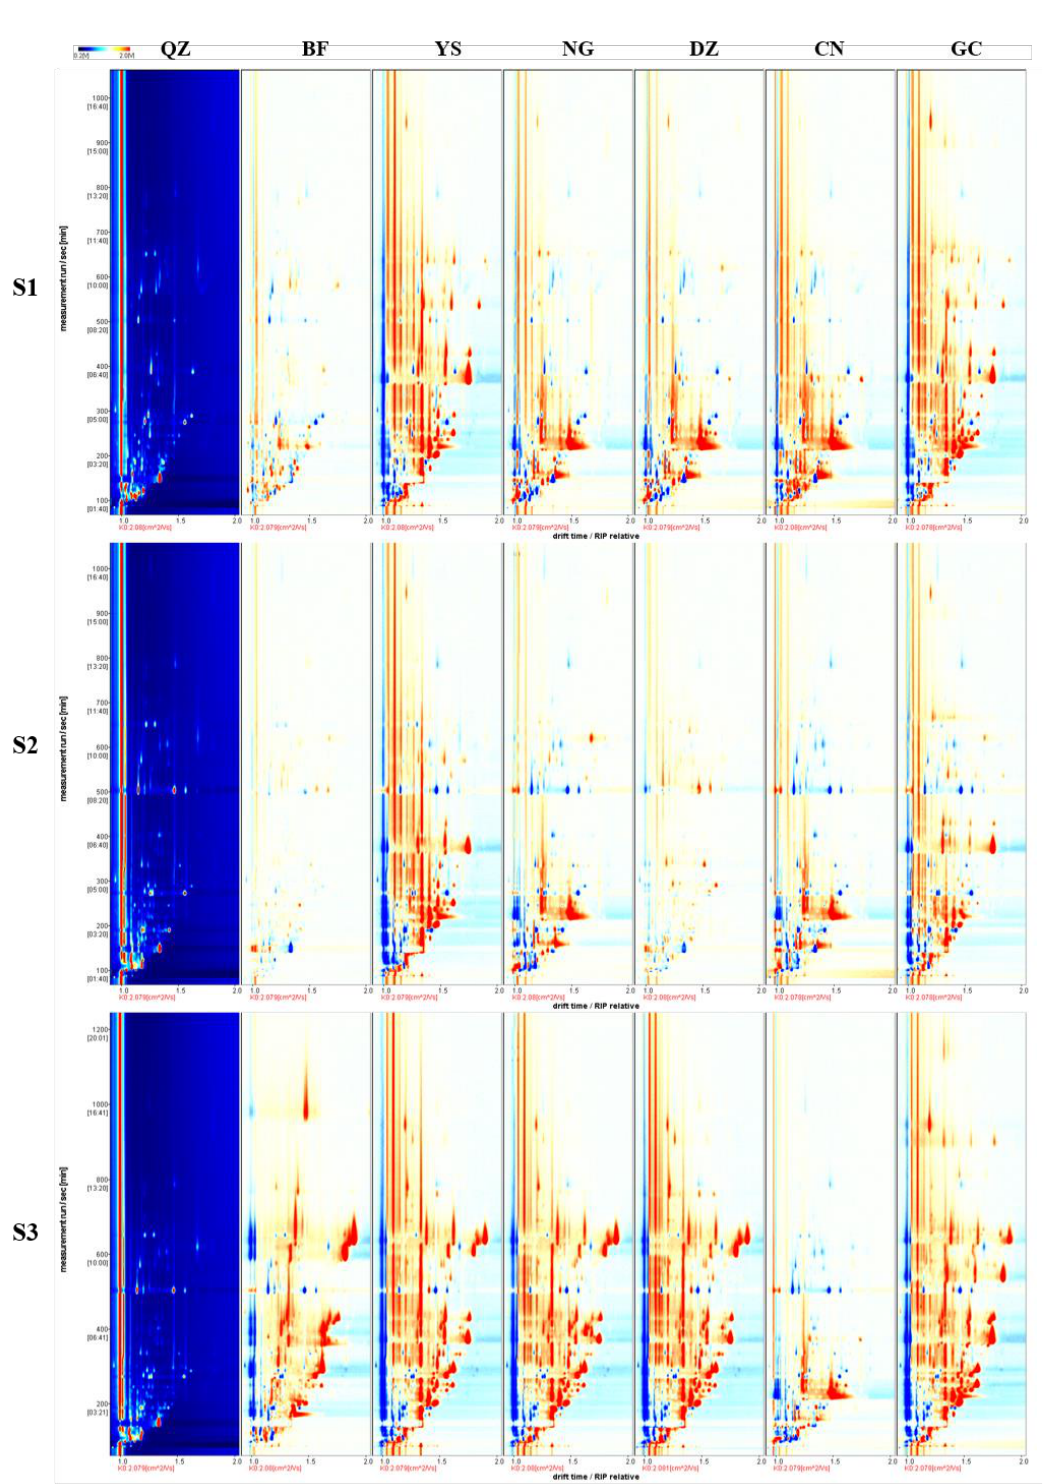
Figure 2. Two-dimensional chromatogram results of volatile fractional compositions in 7 varieties of green plum at three maturity stages.